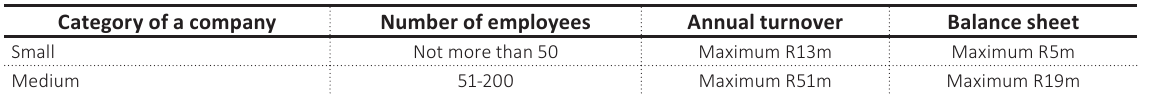
Table 1. Standard size for the definition of small and medium companies in South